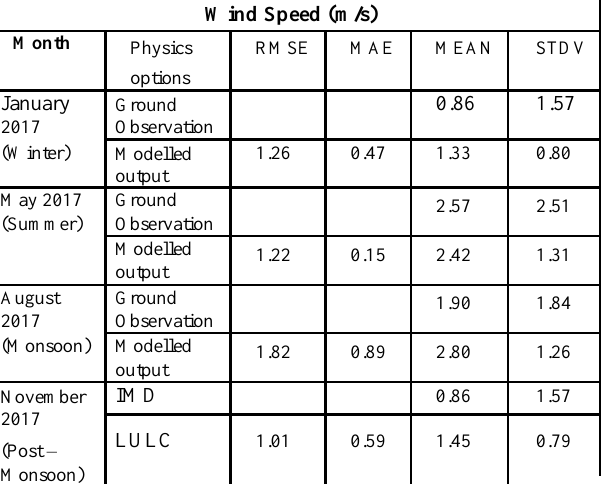
Table6 Validation of the simulated results of Wind